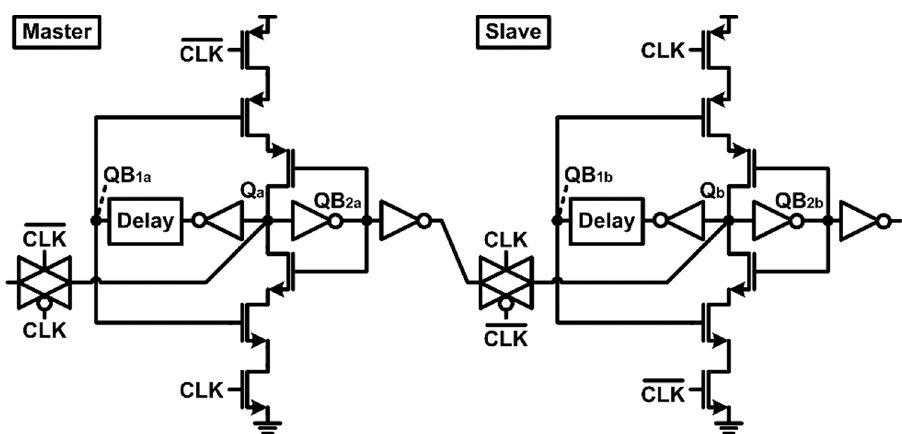
Figure 10. Schematic diagram of the proposed radiation-hardened flip-flop with delay-based dual feedback loops.